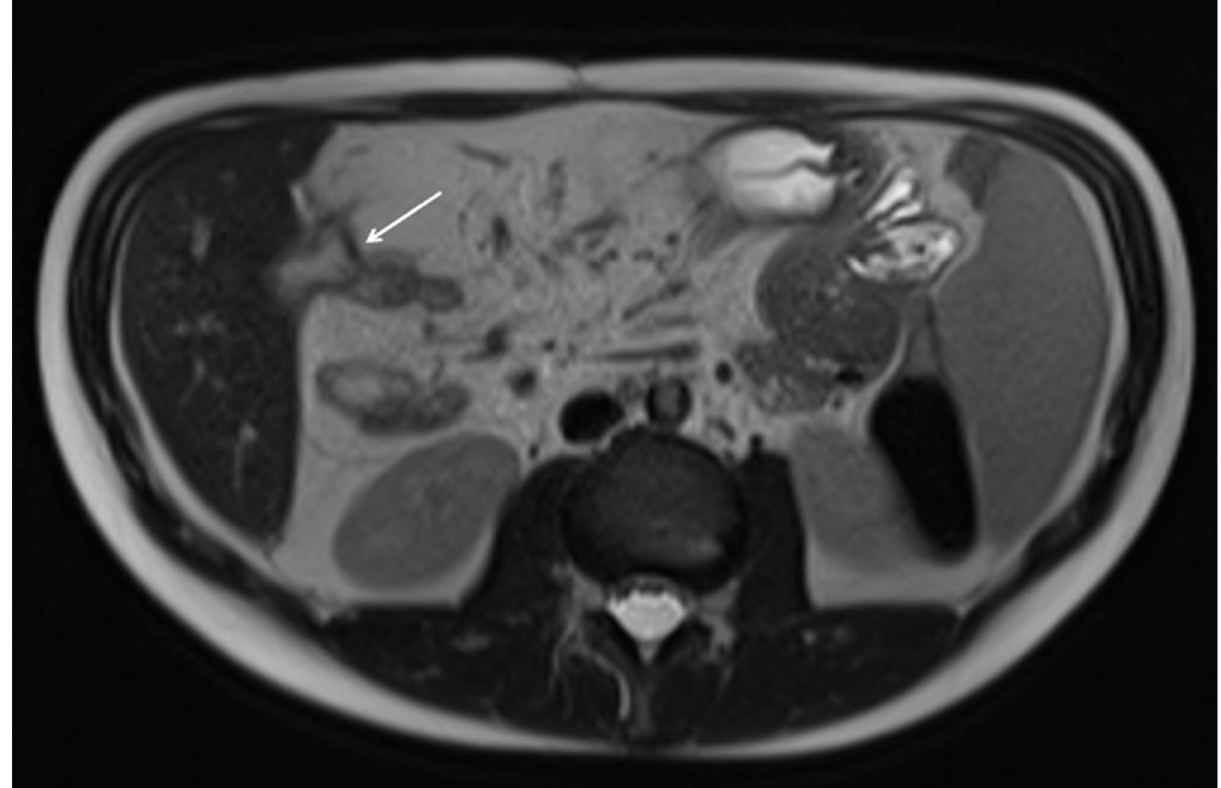
Figure 12. Axial T2 FSE without FS MRE image demonstrates a peri-hepatic abscess in a patients with active CD (white arrows).